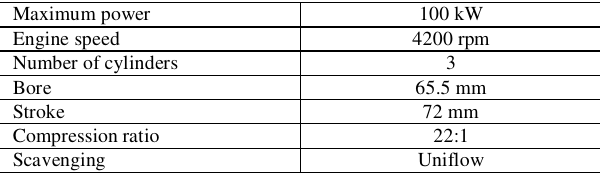
Table 1. Basic technical parameters of the tested engine